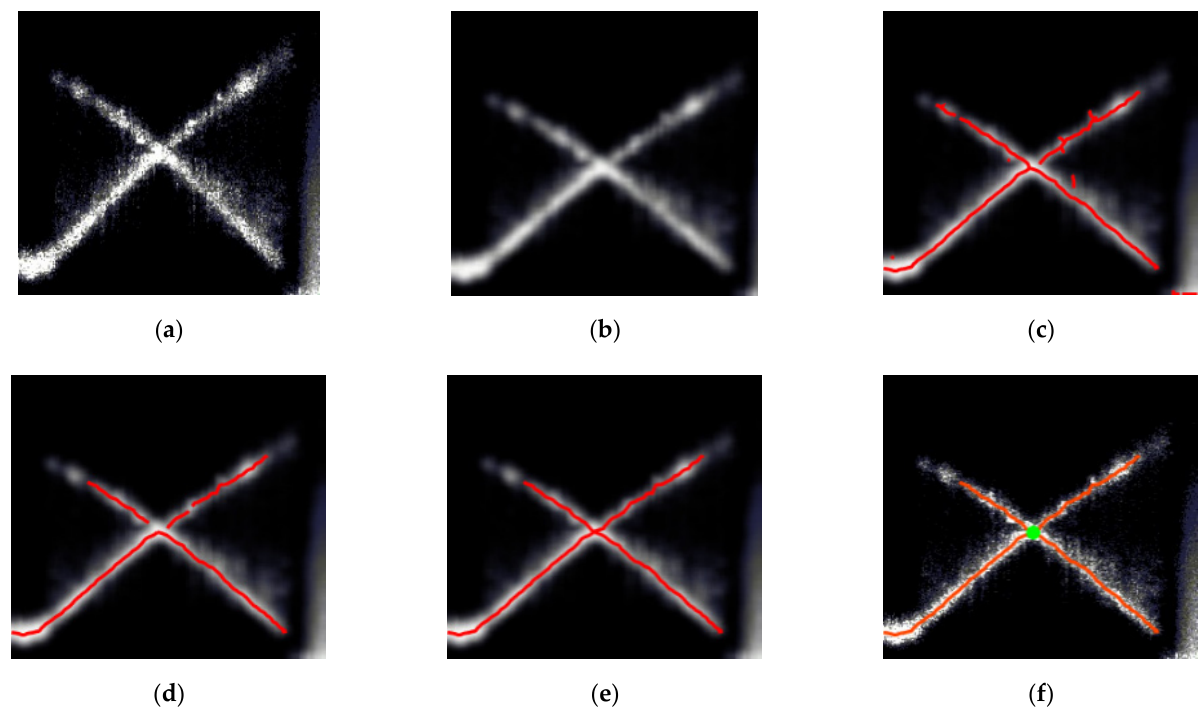
Figure 5. Image processing for the extraction of the groove position: ( a ) Region of interest selection; ( b ) Image smoothing; ( c ) Sub-pixel stripe center extraction; ( d ) Contour selection; ( e ) Contour connection; ( f ) Straight line fitting and intersection.